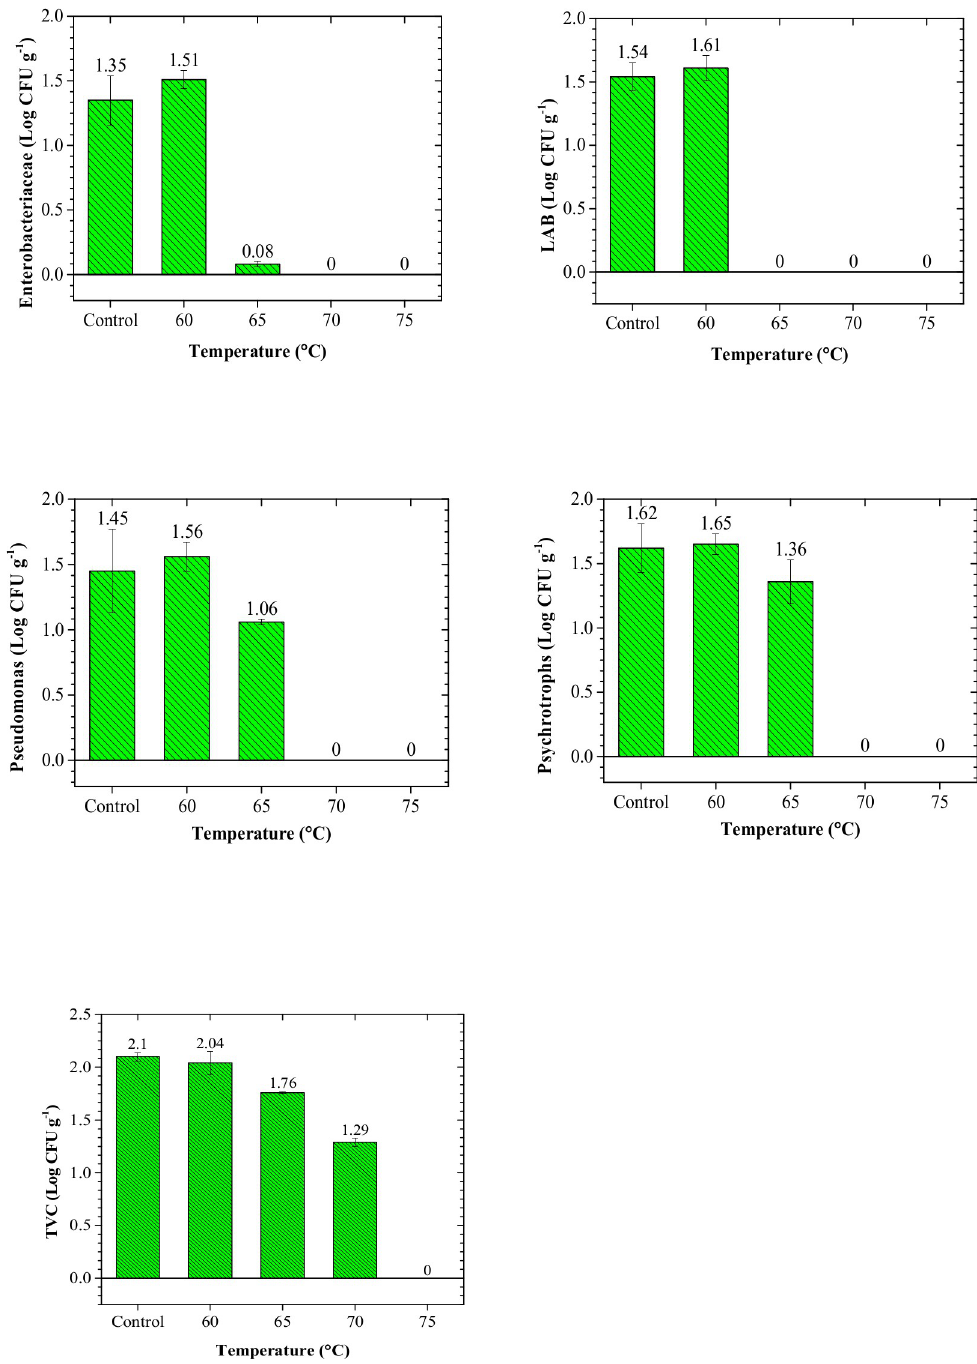
Fig 2. Results of microbial count (Enterobacteriaceae, Lactic Acid bacteria (LAB), Pseudomonas, Psychrotrophs, and total viable count (TVC)) of control and processed samples at time 0 (the day of processing).